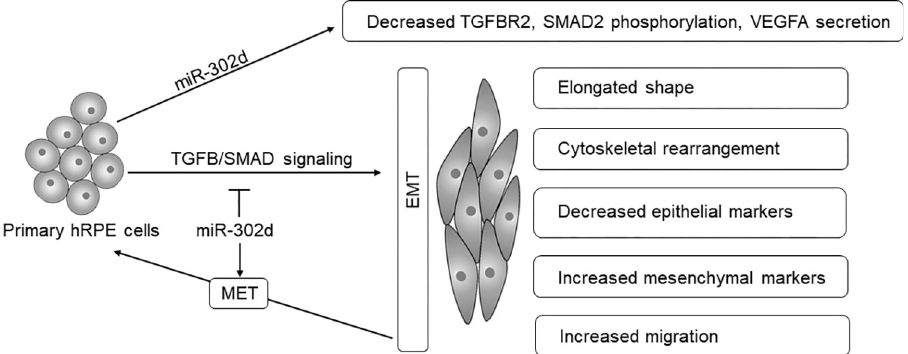
Fig 11. An overall model depicts the effect of miR-302d on TGFB-induced EMT in hRPE